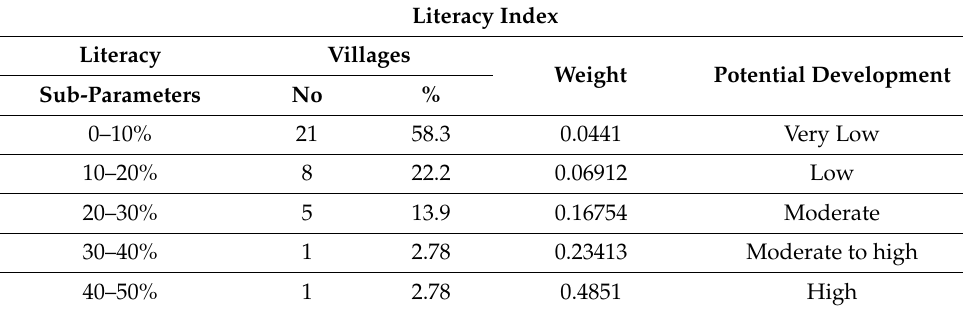
Figure 7. The histogram for the “Literacy” index. Table 8. Classification of the “Literacy” index with their weights.